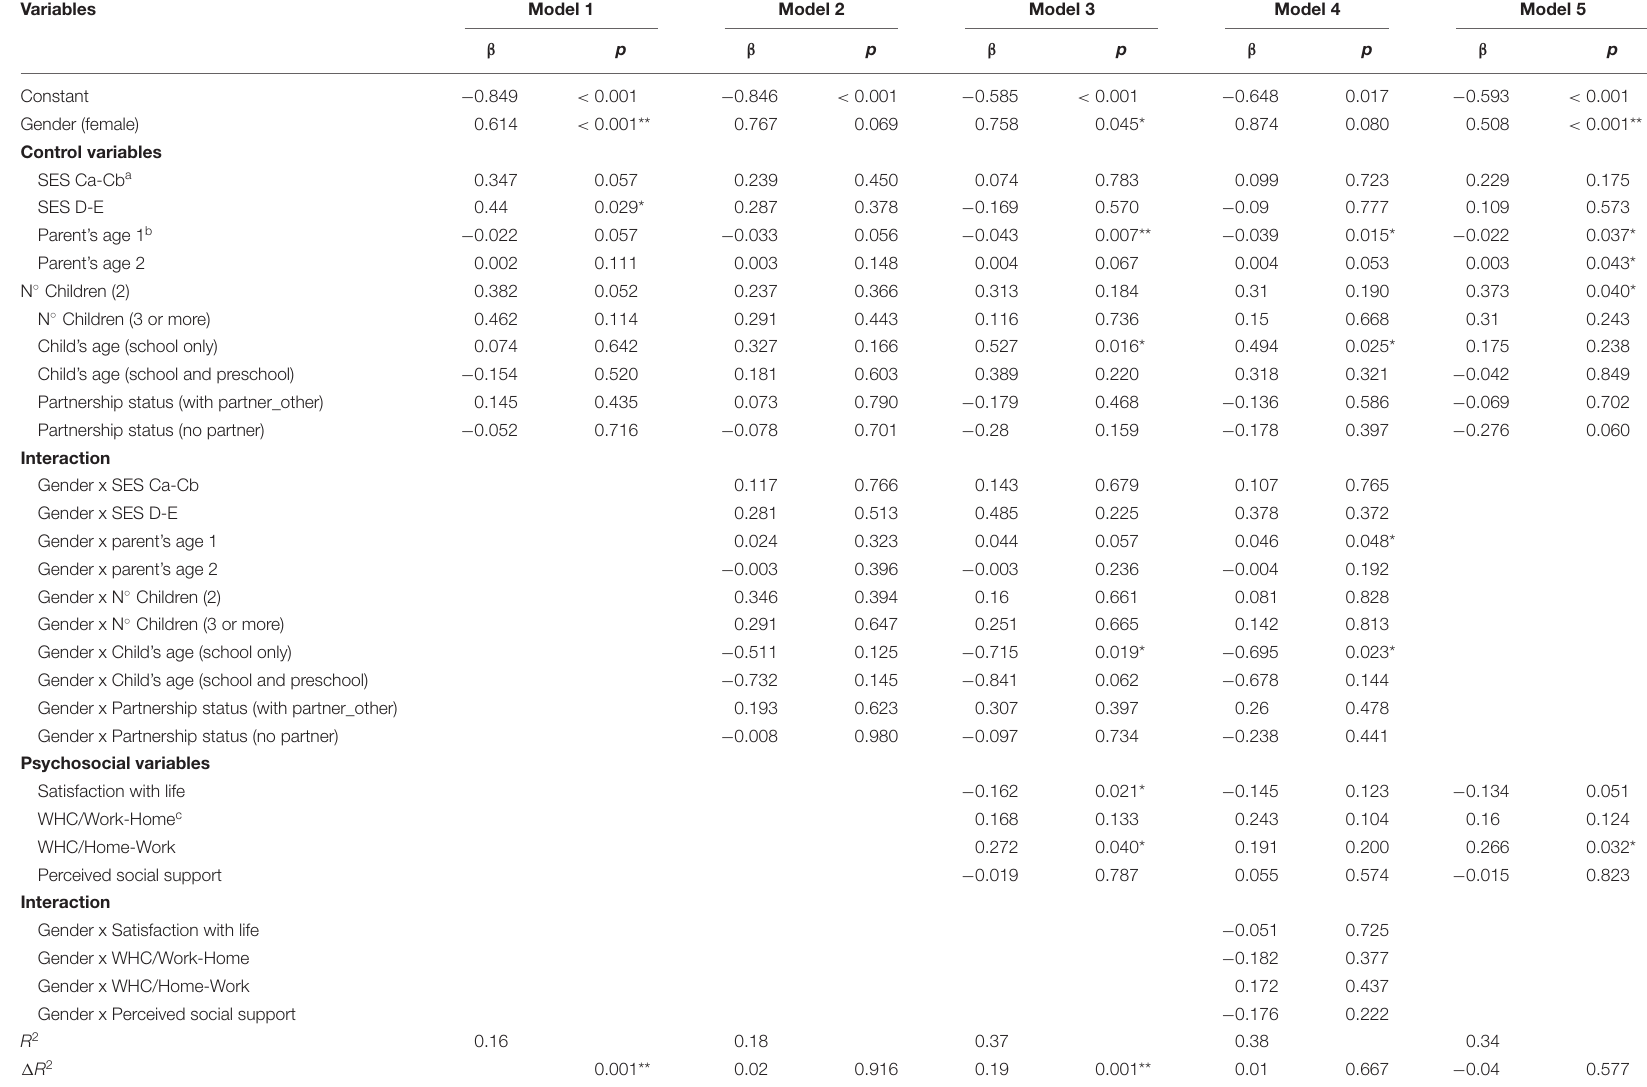
TABLE 3 | Hierarchical multiple regression analysis of parental